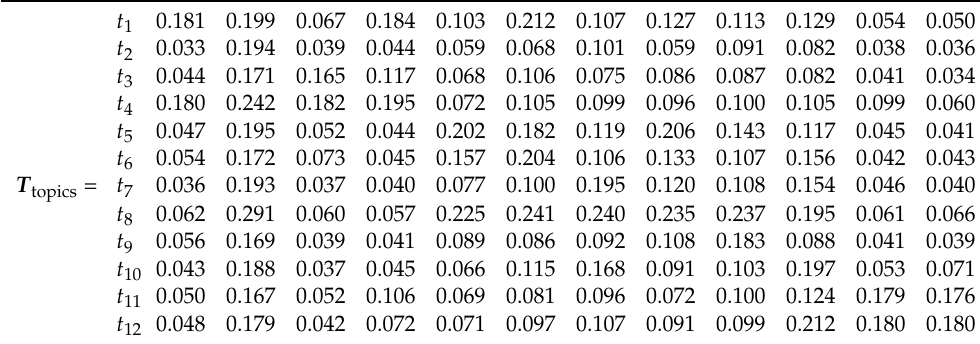
Table 7. The TRM of